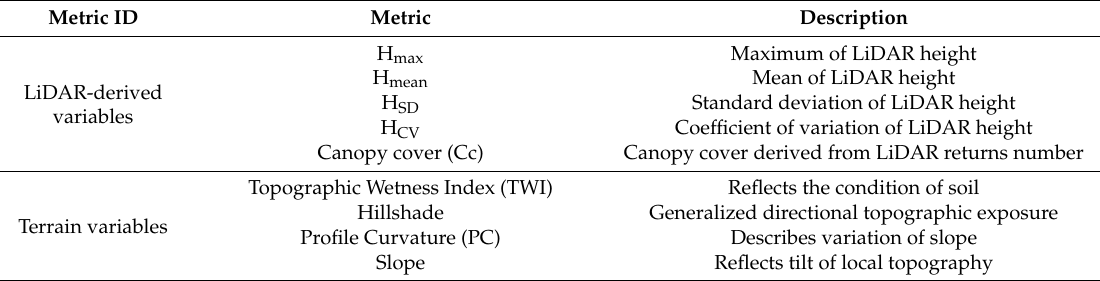
Table 2. Summary of the LiDAR features extraction used in this